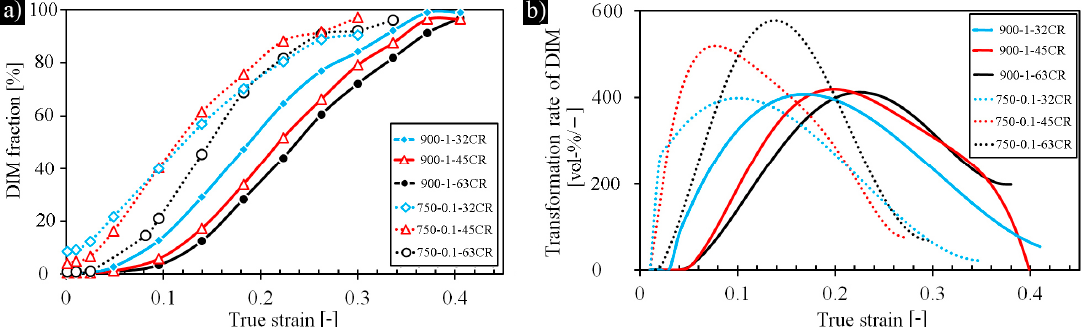
Figure 9. ( a ) Effect of CR reduction on the evolution of DIM fraction and ( b ) transformation rate of DIM under tensile straining (transverse to rolling direction).